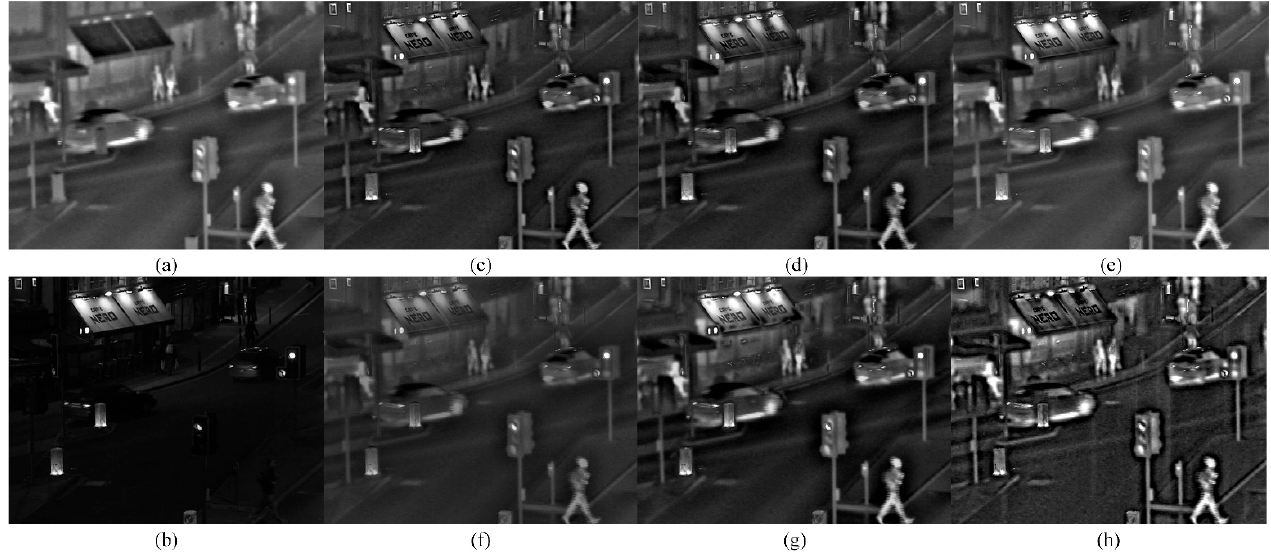
Figure 3. Fused images in the normal dark scene using six different methods. ( a ) Infrared image; ( b ) Visible image; ( c ) MDLatLRR; ( d ) MGFF; ( e ) MSID; ( f ) ResNet; ( g ) RGFF; ( h ) Proposed.